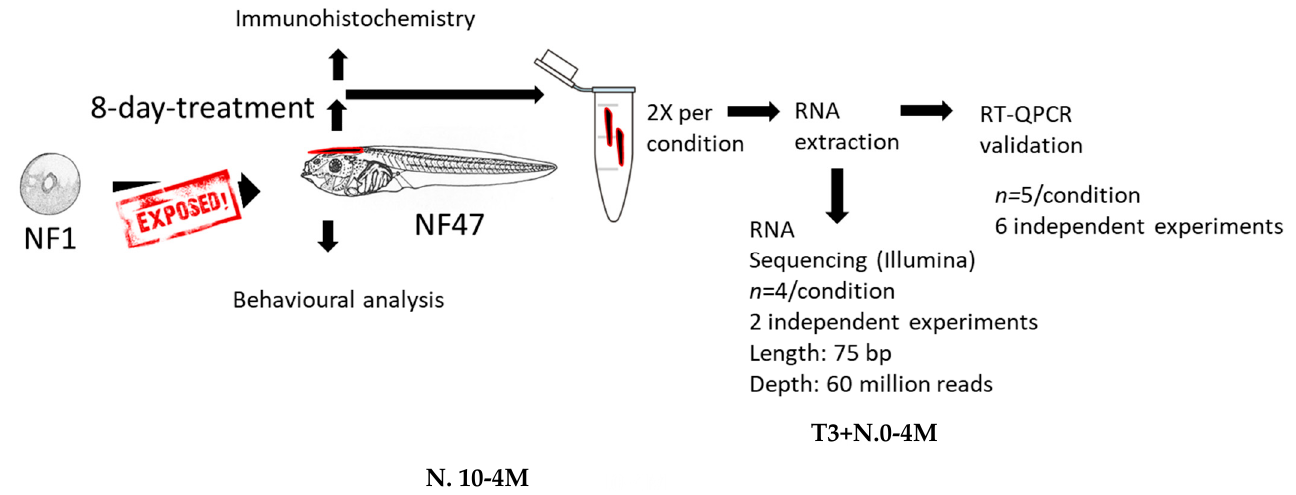
Figure 1. Schematic representation of the conducted exposure study. Fifteen X. laevis tadpoles per group were exposed for 8 days starting just after fertilization (NF 1) to stage NF 47 before gene expression analysis, mobility assays, and brain immunohistochemistry.